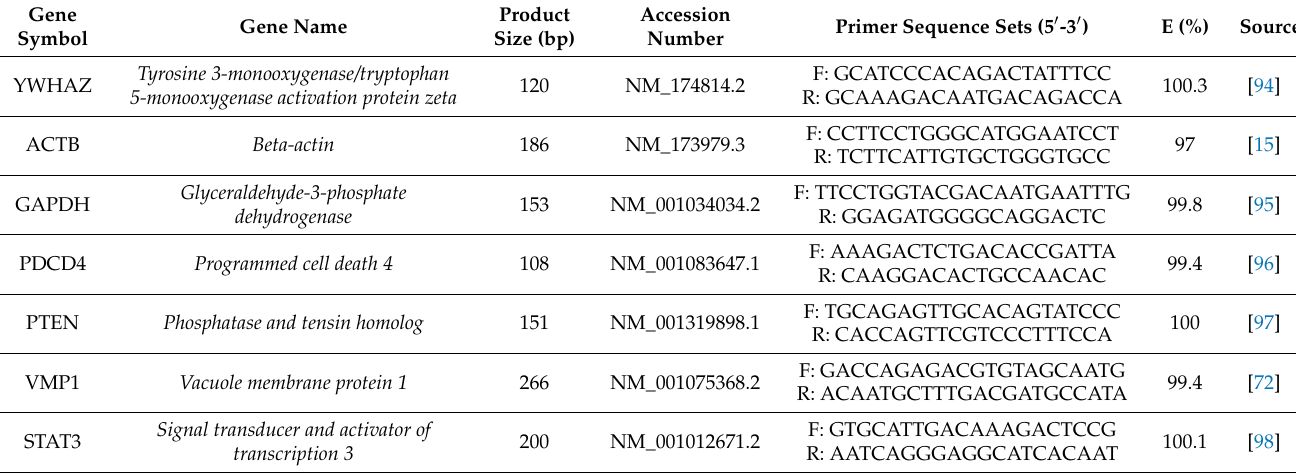
Table 2. mRNA primers for